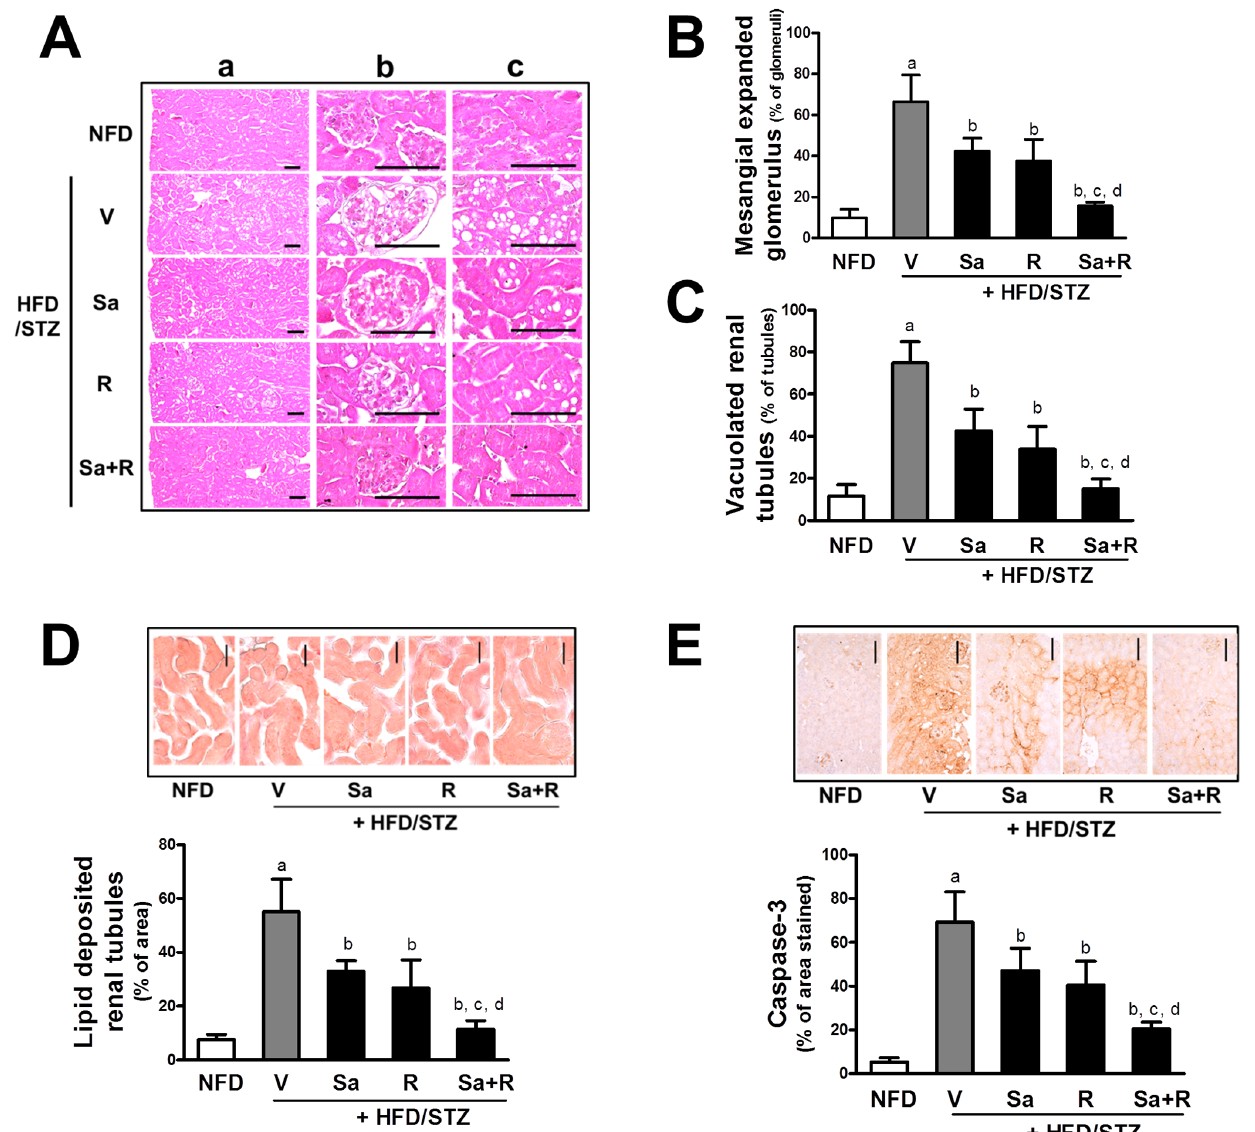
Fig 3. Effects of sarpogrelate and rosuvastatin on histomorphological changes in HFD/STZ mice. (A) H&E staining was performed in kidney tissues and representative histopathological images (cortex (a), glomerulus (b), and renal tubules (c)) are shown. Scale bar = 120 μ m. (B) Numbers of glomeruli that display vasodilation and mesangial expansion were quantified with a computer-based automated image analyzer. (C) Numbers of tubules with vacuolation were quantified. (D) Oil red O staining was conducted and cortex areas with positive staining were quantified with a computer-based automated image analyzer. (E) Immunohistochemical staining was performed with caspase-3-specific antibody. Areas with caspase-3-positive staining were quantified. a P < 0.05 compared with the NFD control group. b P < 0.05 compared with the HFD/STZ group. c P < 0.05 compared with the HFD/STZ + Sa group. d P < 0.05 compared with the HFD/STZ + R group. Two histological fields for each kidney tissue were analyzed. All data represent means ± SD. Scale bar = 120 μ